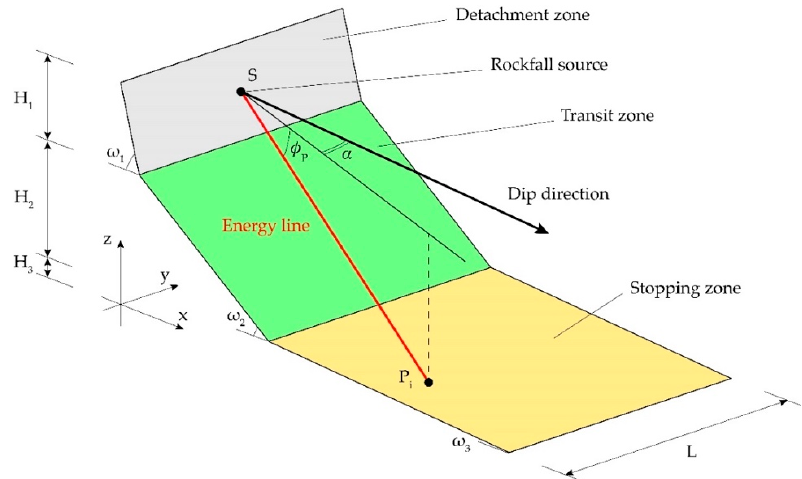
Figure 3. Sketch of the synthetic slope adopted in the present work with indication of the main zones and dimensions. The energy line connects the source point S to the i -th stopping point P i . The energy angle φ p is defined in the vertical plane as the angle enclosing between the horizontal plane (black lines) and the energy line. The lateral angle α is defined by the projection of the energy line on the horizontal plane and the dip direction of the source point.